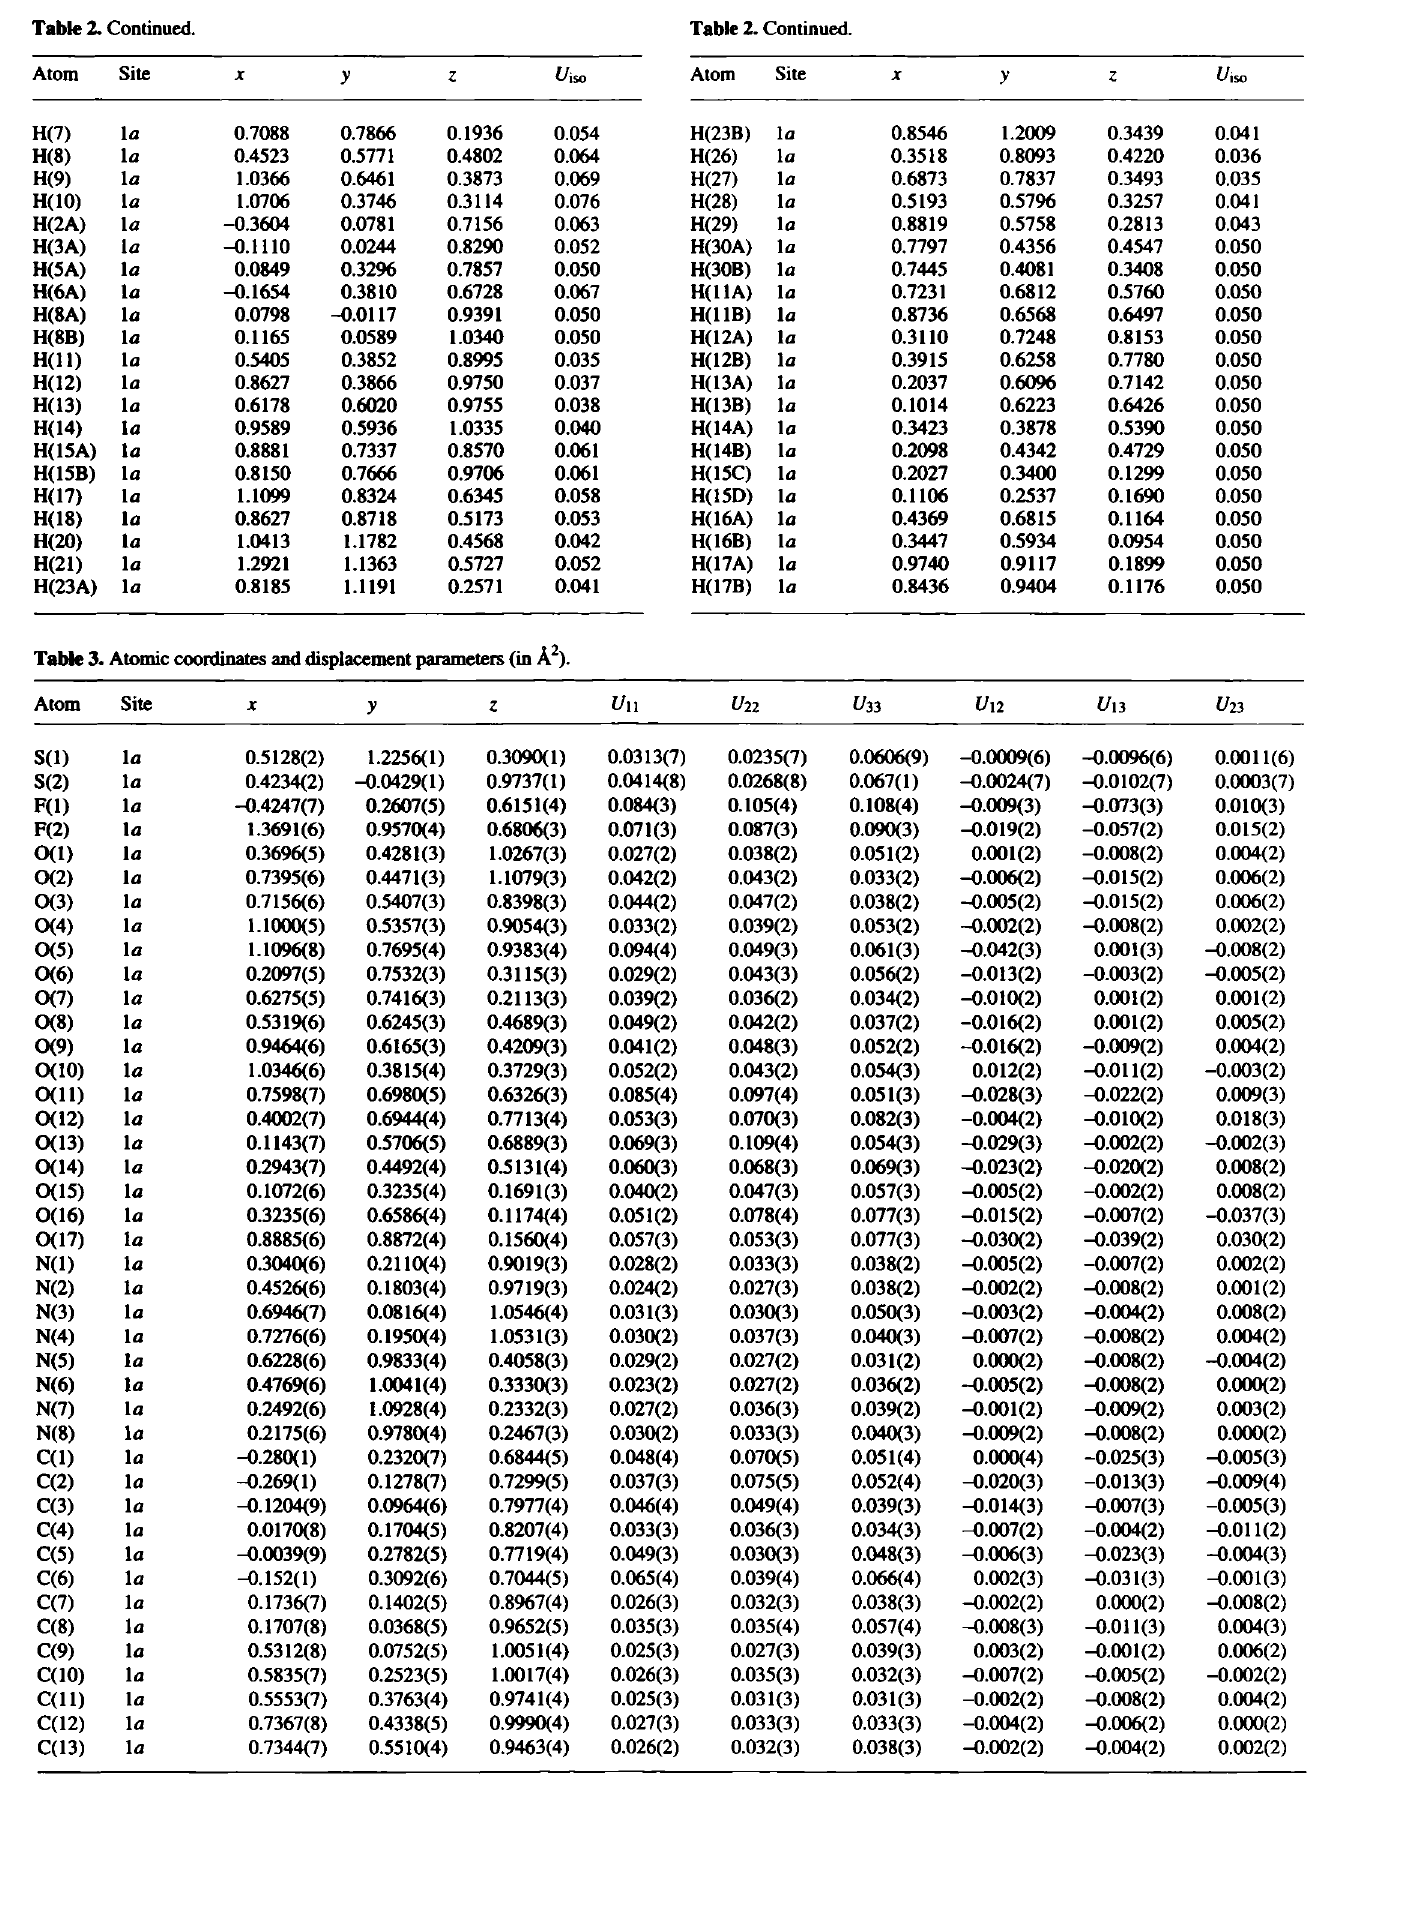
Table 3. Atomic coordinates and displacement parameters (in Â 2